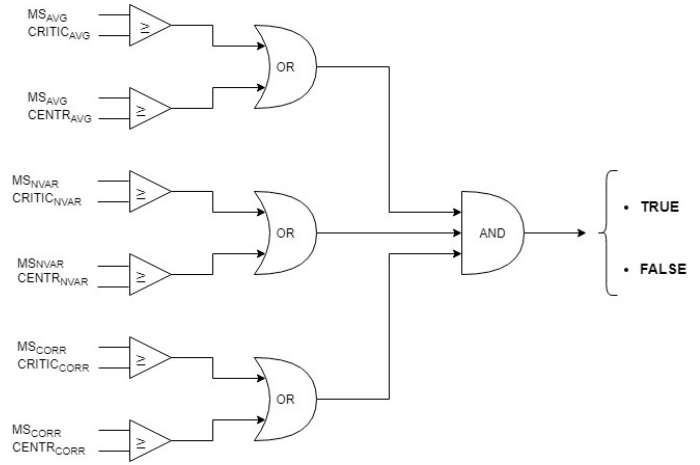
Figure 16. Block diagram of the hybrid threshold based classification algorithm.